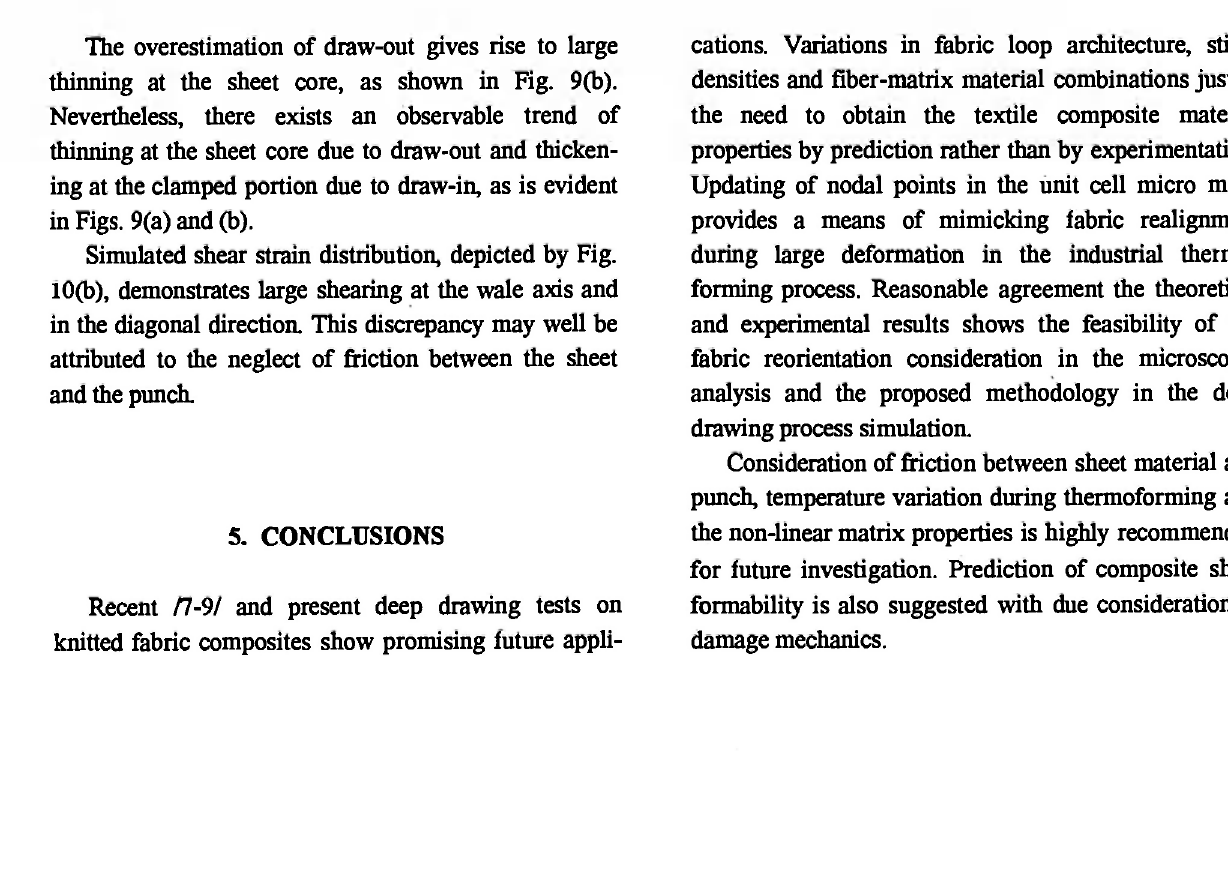
Fig. 10: Shear strain distribution by (a) experiment, Η = 56 nun, (b) analysis, Η = 55